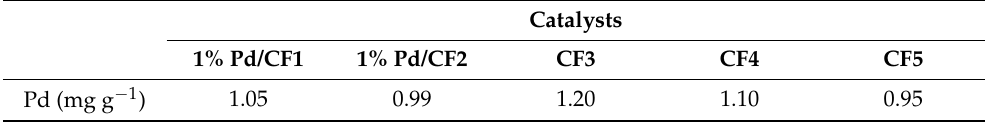
Table 3. Palladium concentration by ICP-OES analysis for each tested